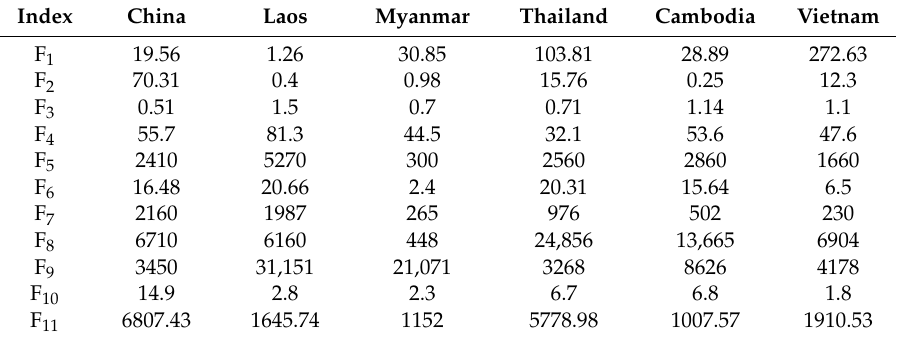
Table 3. Index values of basin countries in the Lancang–Mekong River basin (LMRB).